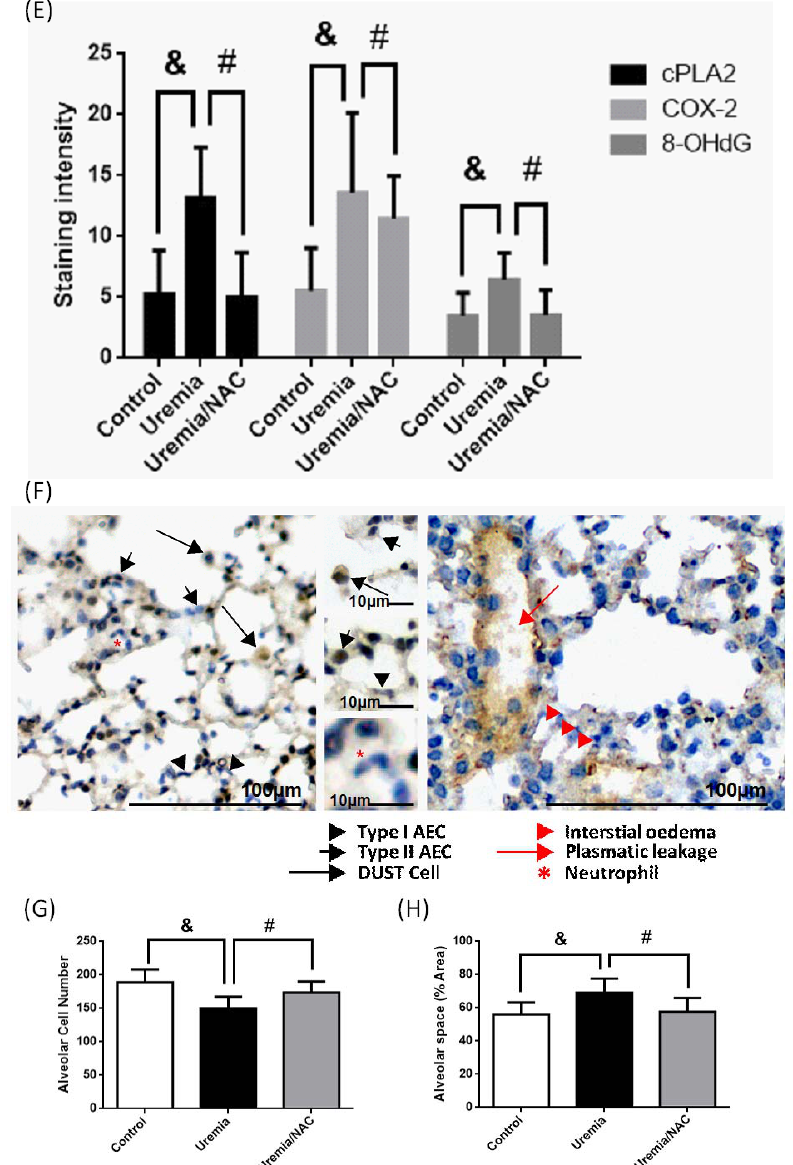
Figure 4. PCS enhances the expressions of COX-2/cPLA2 and ROS and alveolar cell death in uremic lung tissues of CKD mice. ( A ) Working model of CKD-ULI. Mice were randomized into three groups: vehicle-treated control group (normal renal function), uremic group, and uremic group with inhibitor (NAC) treatment. The uremic group was induced with aristolochic acid nephropathy and PCS (10 mg/kg i.t., one time for 3 days before sacrificed) was placed posterior in the throat with the support of otoscope and aspirated into lungs at week 12. For uremia/NAC group, NAC (1000 mg/kg) was i.p. injected 1 h prior to PCS treatment. At the end of treatment, mice were scarified and lung tissues were extracted and paraffinized. immunohistochemical stain was performed to detect ( B ) cPLA2, ( C ) COX-2, and ( D ) 8-OHdG. ( E ) Quantification of immunohistochemical images were performed by image J. ( F ) Closer images of immunohistochemical stain to show the indicated cells or phenomena. Quantification of alveolar cell number ( G ) and alveolar space ( H ). Data are expressed as mean ± SEM ( n = 5); & p < 0.05 and # p < 0.01 to compare the differences between the two indicated groups.